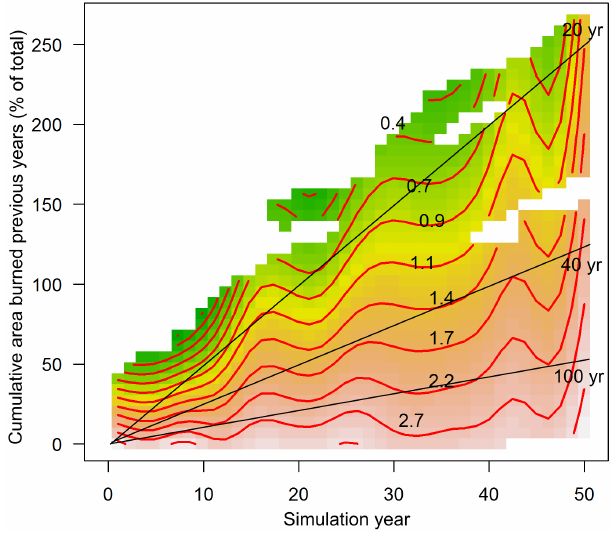
(Fig. 7, X = year 20 , Y = 50%), the estimated rate of burning for subsequent years is estimated at ca. 1.7% per year. At the same rate of burning over a longer time frame (Fig. 7, X = year 40, Y = 100%), the estimated rate of burning for subsequent years is about 1.4% or a 18% decrease in the annual area burned. A wide range of fire rotation intervals in the simulation outputs. Fig. 7 . Contour plot of expected area burned in the current year (% total) conditional on simulation year and cumulative area burned in all previous years. Black lines show reference fire rotation intervals, or number of years to burn an area equal to the entire study area. The average area burned per year for all simulations was 2.2% or a fire rotation of about 45 years. Contours show a 10-year periodicity that corresponds to the modeled vegetation regrowth after fires.